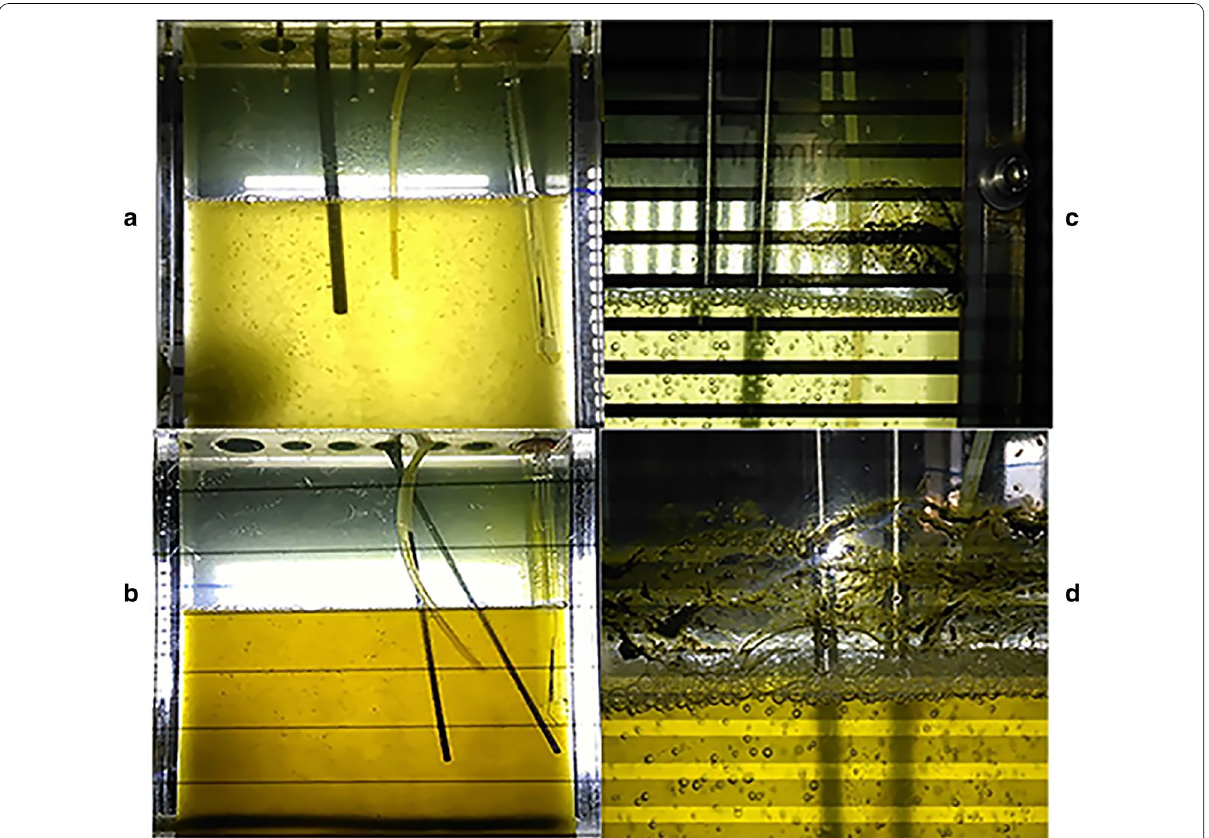
Fig. 2 Traits of algae at different temperatures. a WT at 42 °C, b IM at 42 °C, c WT at 45 °C, d IM at 45